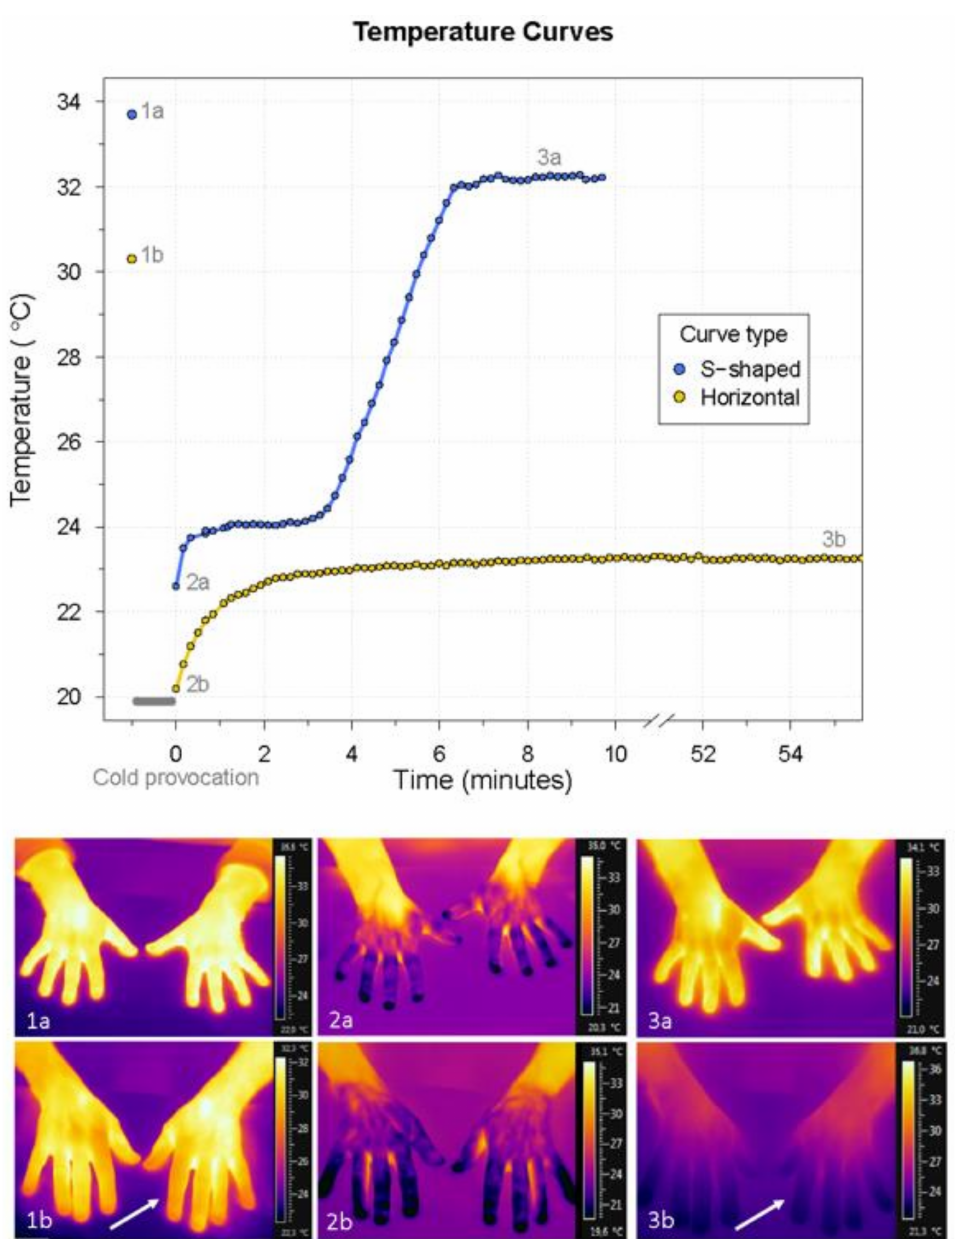
Figure 4. The two curve types identified during the analysis of the thermographic temperature curves. The numbers 1–3 refer to the time points of baseline, immediately after cooling, and at the end of the thermographic examination, respectively. These time points correspond to the temperature variables t base , t 0 , and t end , respectively. The thermographic images associated with the mentioned time points are shown. The gray bar marks the time of the cold provocation. The top bar of the thermographic images shows the hands of a healthy participant ( a ), while the bottom bar presents the hands of a patient with RP ( b ). Note the lower temperature in the fingers of the patient compared with the healthy participant, especially at baseline and at end temperature (arrows). t base = baseline finger temperature; t 0 = finger temperature immediately after cooling; t end = end